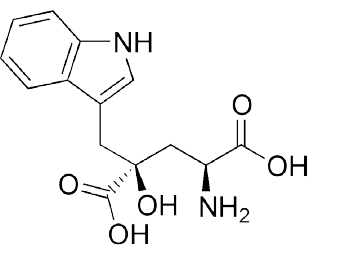
Fig. 10: Monatin, an indole-derived sweetener from Sclerochiton ilicifolius Safety of